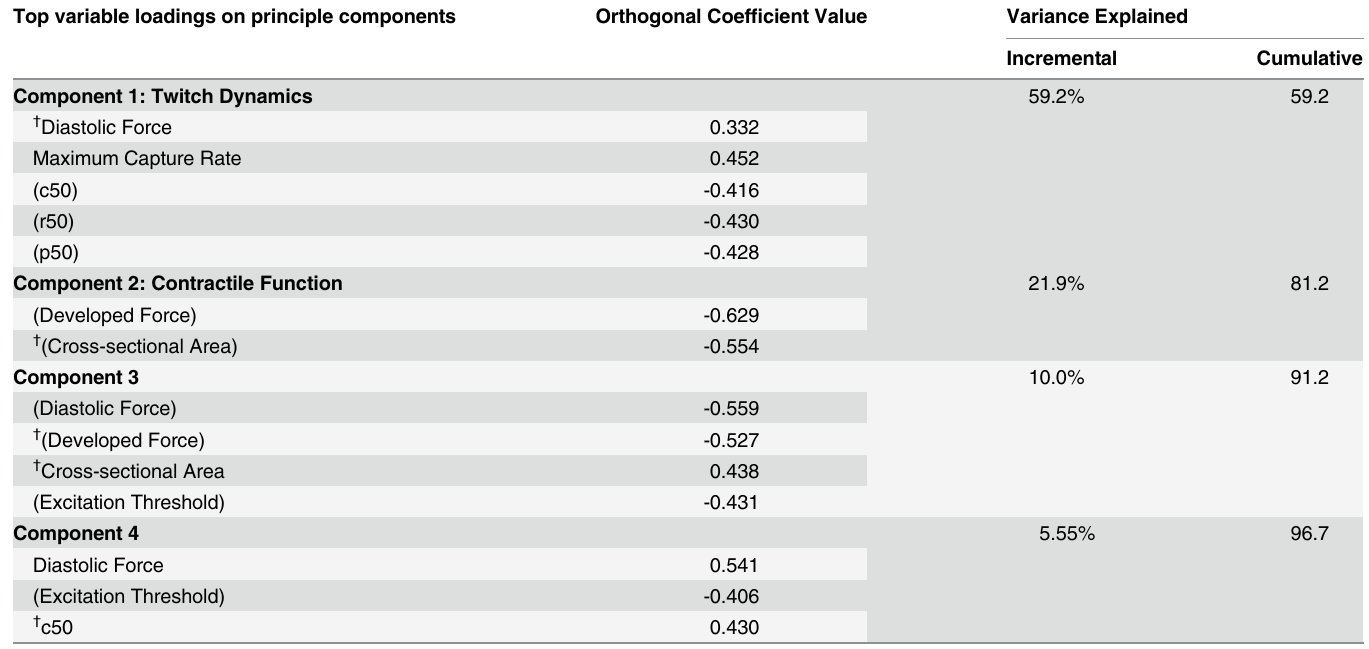
Table 2. Summary of component loadings on the principal components that explain 95% of the variance on experimental day